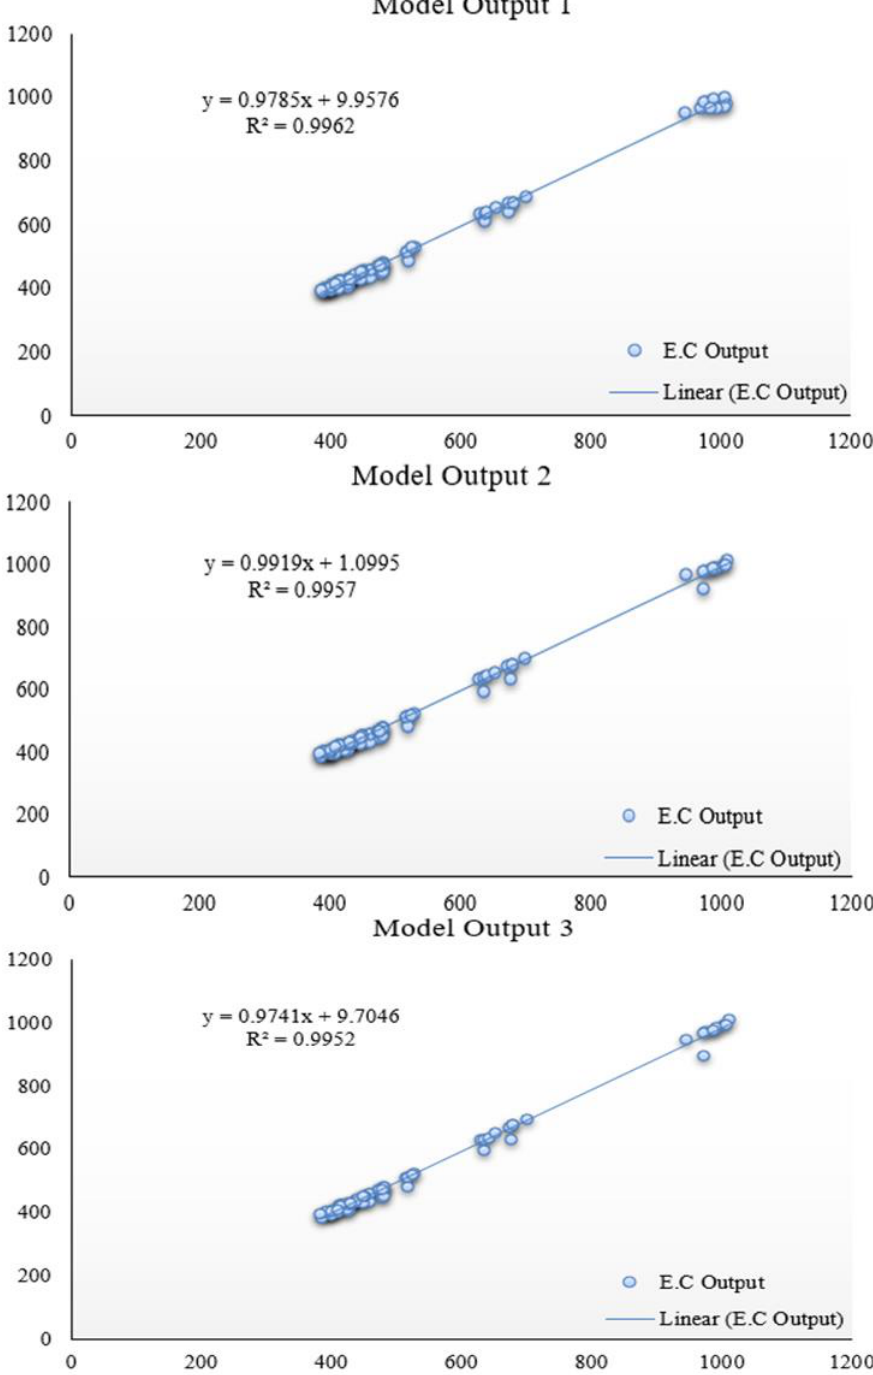
Fig. 5. Scatter plot of predicted and observed EC in